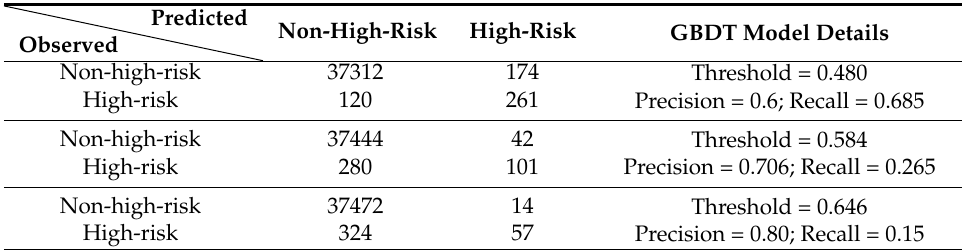
Table 3. Confusion matrix of GBDT models for the testing dataset of 2016–2017 period with different